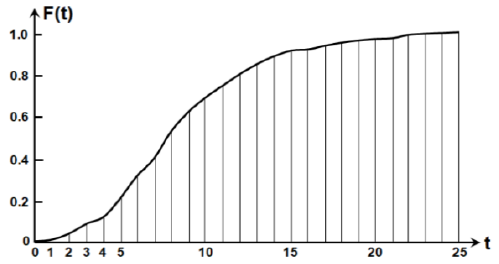
Figure 1. Probability density function F(t).